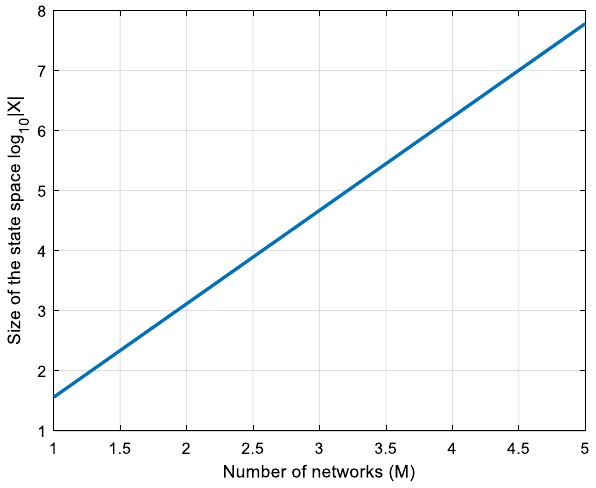
Fig. 5 Size of the state space with respect to the number of net- works where M = 3 and 𝚫 =